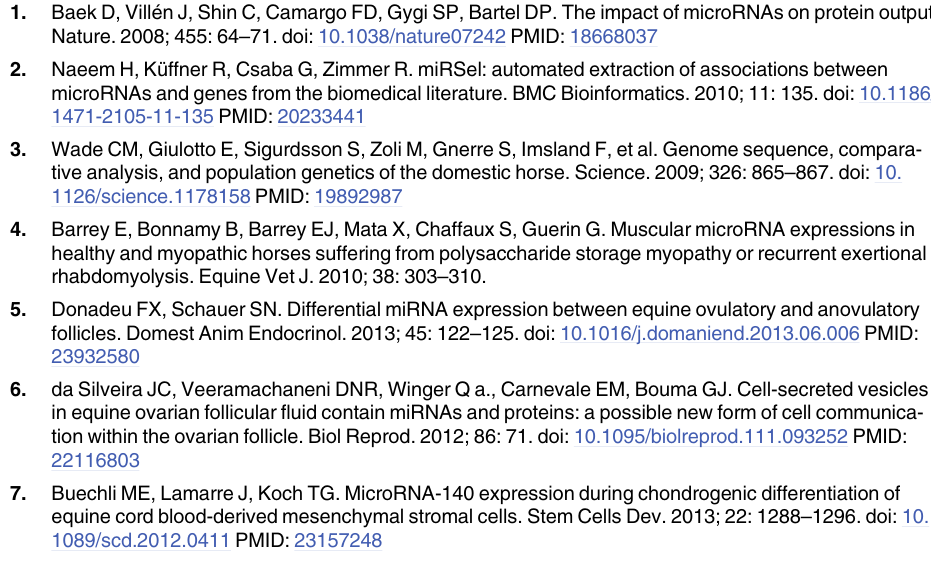
S1 Table. Five most abundant putative novel miRNA species in horse plasma. Location rep- resents the chromosome on which the miRNA genes are located, start and end sites, and either sense [+] or antisense strand [ − ]. S2 Table. MiRNA species that showed higher levels of expression (CPM) in the plasma compared with the liver, colon, and muscle tissues. S3 Table. MiRNA species that showed lower levels of expression (CPM) in the plasma com- pared with the liver, colon, and muscle tissues. S4 Table. Ten most abundant miRNA species in the horse colon, muscle, and